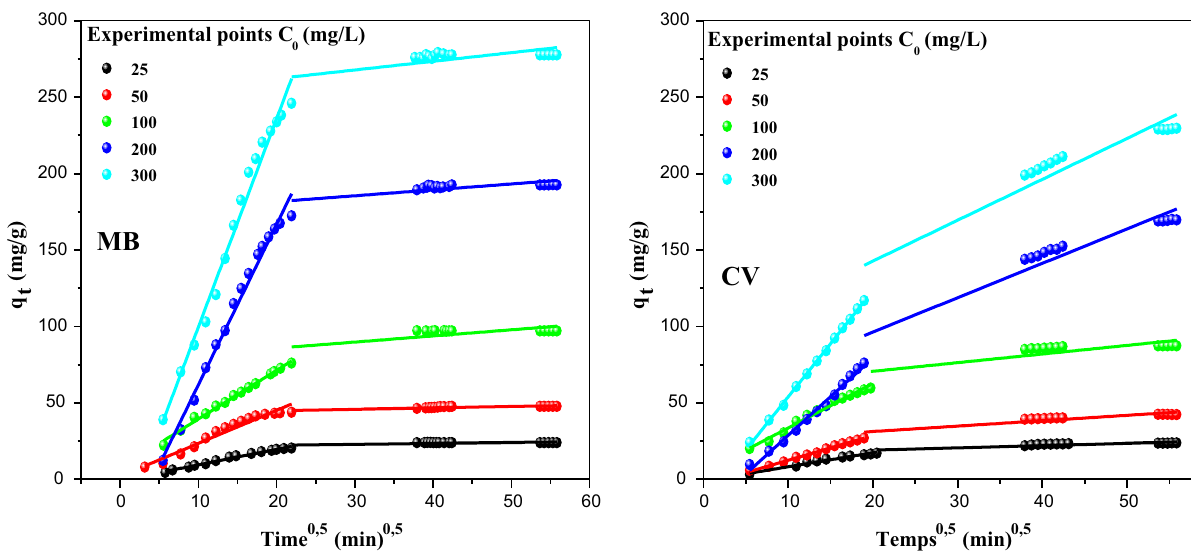
Fig. 9 Intraparticle diffusion model for dyes adsorption onto ABent/A Table 4 Intraparticle diffusion data for the adsorption of dyes onto